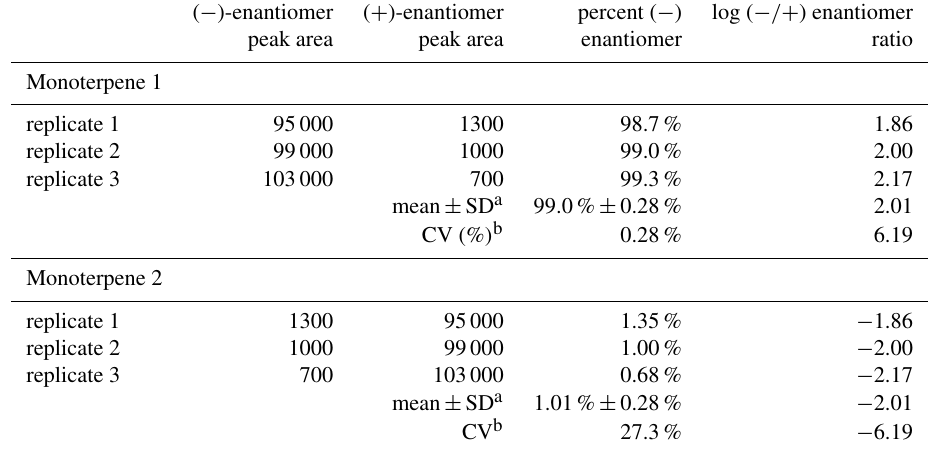
Table 6. Hypothetical enantiomer peak area data with associated percent ( − )-enantiomer values and associated statistical values. ( − )-enantiomer ( + )-enantiomer percent ( − )